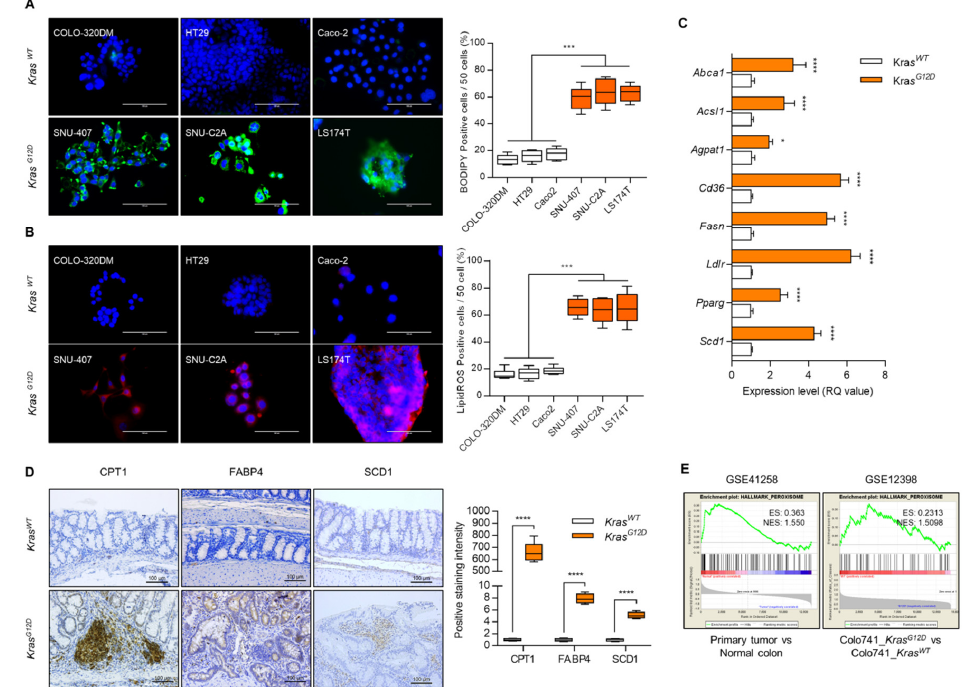
Figure 1. Dysfunction of lipid metabolism in Kras G12D colorectal cancer (CRC) cells. ( A ) BODIPY staining and ( B ) lipid reactive oxygen species (ROS) staining using Kras G12D and Kras WT cell lines. Positive cells were counted for every 50 cells in 3 different fields at 400× magnification. Results shown are representative of at least 3 independent experiments. Scale bars: 100 μm. ( C ) Expression level of genes involved in lipid metabolism in Kras G12D CRC cells and presented as the fold change of Kras WT CRC cells. Rn18s was used as an endogenous control. Results are representative of at least 3 independent experiments. ( D ) Immunohistochemical staining with CPT1, FABP4, and SCD1, and positive cells were counted ( n = 4). Scale bars: 100 μm. ( E ) GSEA analysis using GEO datasets (CRC patient biopsy dataset, GSE41258 and Kras G12D transfected CRC cell line dataset, GSE12398). Values are presented as means + SD. A two-tailed Student’s t -test was used for statistical analysis. * p ≤ 0.05, *** p < 0.001, **** p < analyzed the expression levels of 94 peroxisomal genes listed in the peroxisome database [22] and